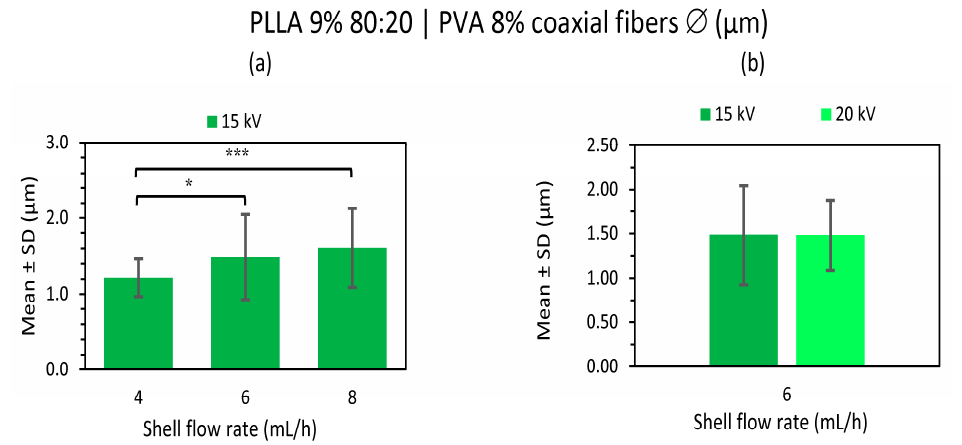
Figure 9. Mean and standard deviation of the diameters of 9% PLLA 80:20 (shell) and 8% PVA (core) 0.5 mL/h coaxial microfibers manufactured at 4, 6 and 8 mL/h shell flow rate with 15 cm and 15 kV ( a ), and at 6 mL/h shell flow rate with 15 kV compared with 20 kV ( b ). Core flow rate 0.5 mL/h in both cases, at (*) p < 0.05, (***) p < 0.001 statistically signi fi cant di ff erences. The micro fi ber morphology of these PLLA 9% 80:20 and PVA 8% core fi bers had rough fi ber surfaces with pores in the FESEM images, but without bead formations. The thinnest and smoothest surface was obtained in the sample produced at 2 mL/h core fl ux at 20 kV (Figure S20) and 6 mL/h shell fl ux at 20 kV (Figure S22). In the coaxial micro fi bers manufactured at 0.5 mL/h (Figure S18) and 1 mL/h (Figure S19) at 20 cm and 20 kV, one could speak of the presence of two or three fi ber diameter distributions, respectively, with “ fi ne fi bers” of between 0.9 and 2.1 µm and “intermediate